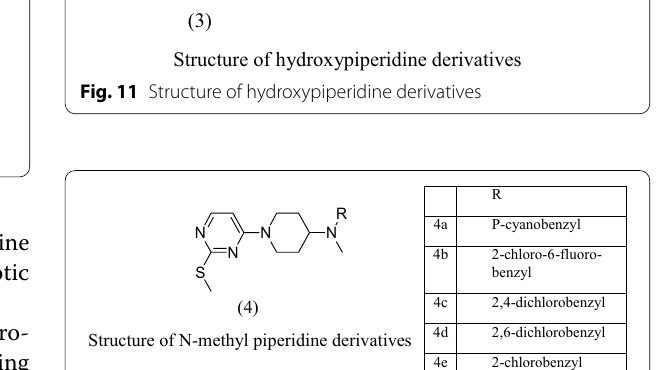
Fig. 8 Structure of evodiamine